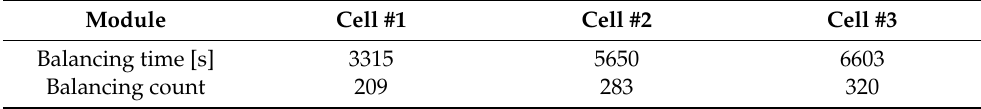
Table 8. Balancing parameters from module #3.